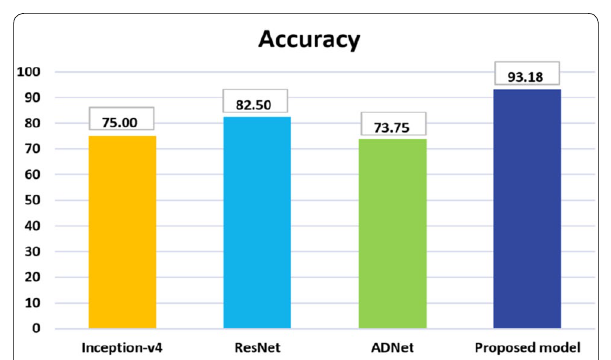
Fig. 10 Comparison of accuracy on the OASIS dataset